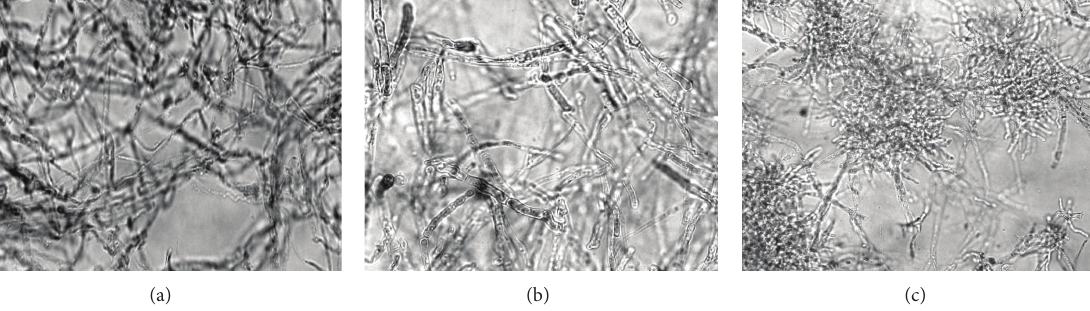
Figure 3: Hyphal morphology depending on Se concentration in the medium. (a) Control, (b) 100.0mg L −1 , and (c) 500.0 mgL −1 ( × 630).